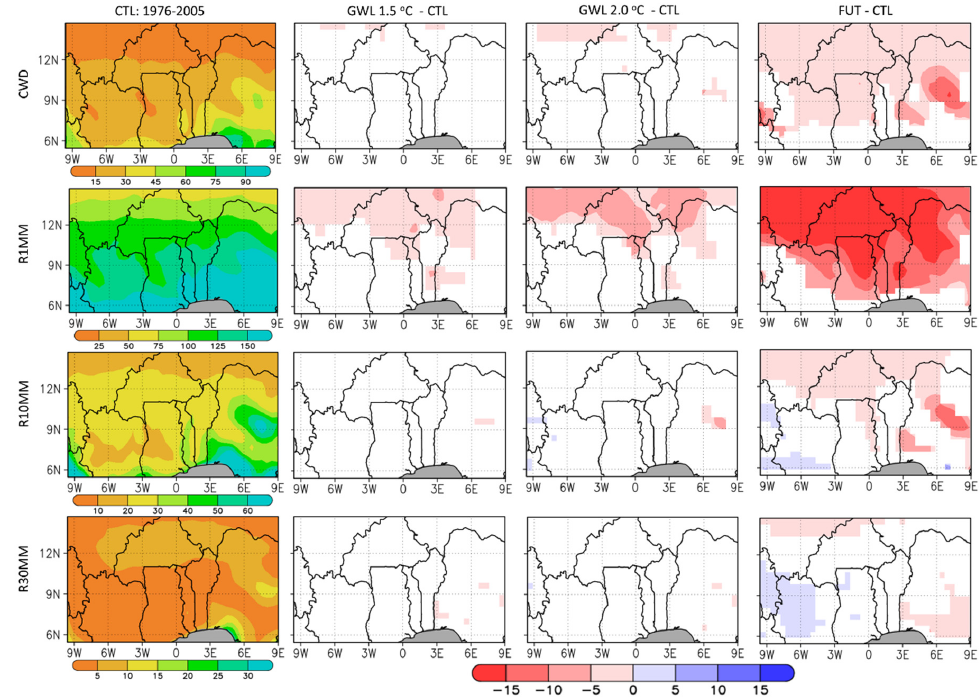
Figure 3. As in Figure 2 but for CWD, R1MM, R10MM, and R30MM. All units are in days/year. An average of about 50 rainy days (R1MM) were recorded in the north of the study domain and at least 150 days/annum in the south. Most of the domain recorded between 10 and 30 days of wet days with moderate intensity precipitation (R10MM). For wet days with heavy intensity precipitation (R30MM), most of the domain recorded less than 15 days/annum. No major significant changes were recorded over the domain for R1MM, R10MM, and R30MM, save for a slight reduction of up to 10 days/annum, especially for R1MM over some areas north of the domain. Over the future (FUT) period, the greatest change (exceeding 15 days/annum in most of the domain) was expected for R1MM. R10MM and R30MM recorded a slight reduction of about 5 days/annum in many parts of the domain except the south-west where an increase of about 5 days/annum was recorded. Overall, the 1.5 °C and 2.0 °C global warming levels did not show significant effect on precipitation over many parts of the study domain. Specifically, all precipitation descriptors recorded a reduction under the two warming scenarios except SDII which recorded an increase. The northern part of the study domain recorded most changes compared to the south. Considering the future